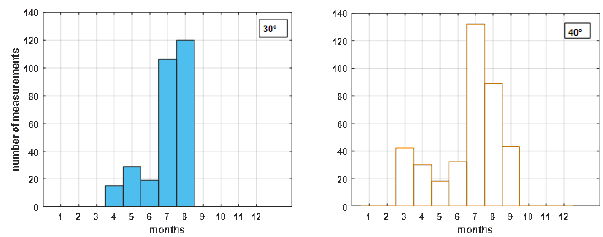
Figure 4. Number of measurements available for each zenith